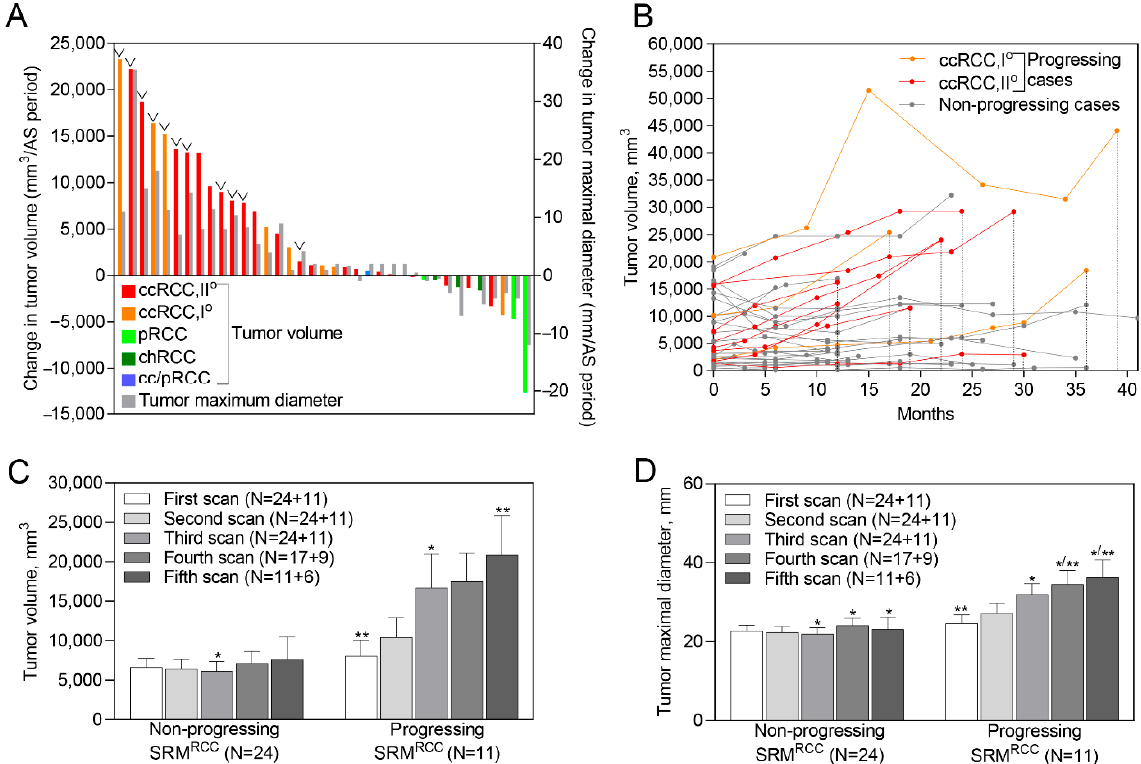
Figure 1. Growth kinetics of biopsy confirmed SRM RCC. ( A ) Waterfall plots of tumor growth rate during all AS periods. ( B ) Tumor growth kinetics at different time points of the AS period. ( C , D ) Average tumor size at different scans. Whiskers indicate the standard error of the mean. ˅ indicates progressing cases; * indicates significant differences between the groups (Non-progressing vs. Progressing); ** indicates significant differences within the group (between the first scan